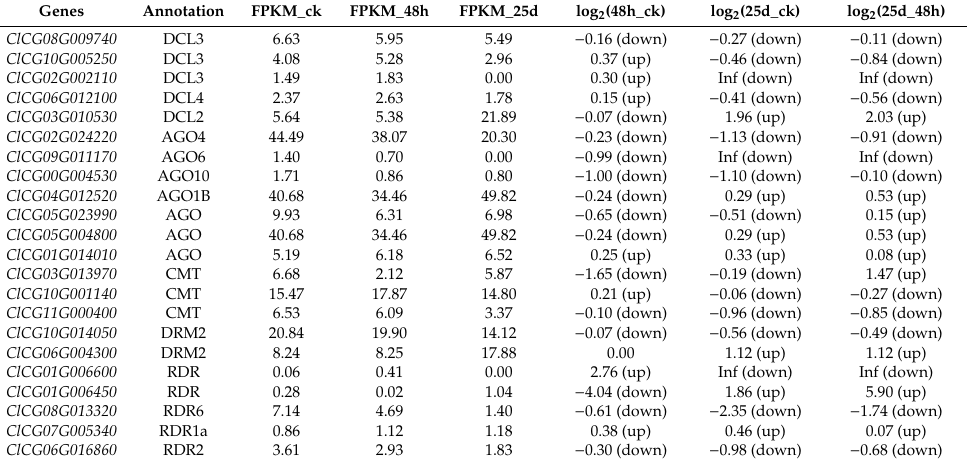
Table 3. Expression of genes involved in the RdDM pathway and RNA interference in watermelon.